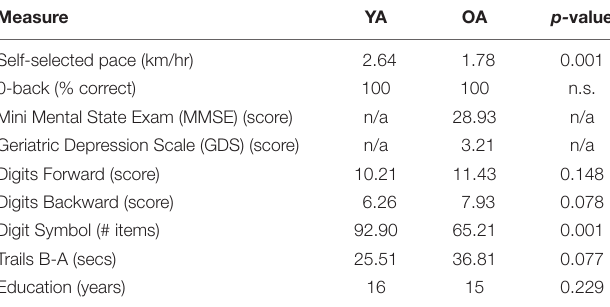
TABLE 1 | Mean values for the demographic and neuropsychological data of younger (YA) and older (OA) adults. Measure YA OA p- value